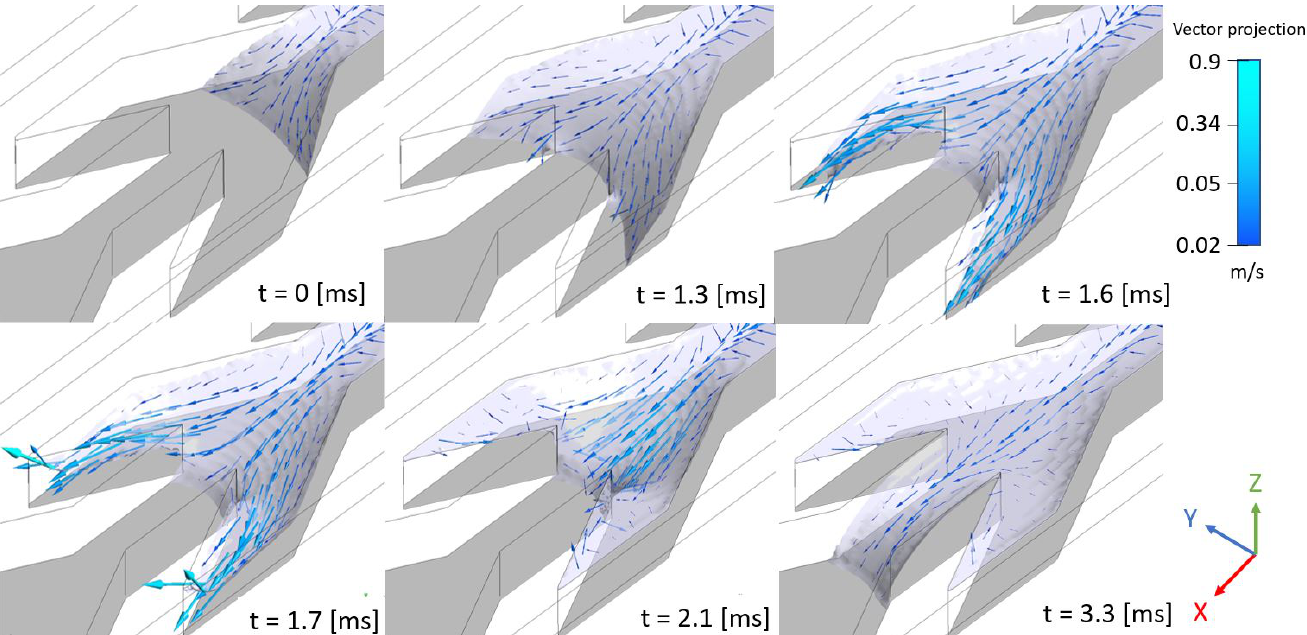
Figure 13. VOF simulation detailing fin filling in the x direction. The continuous color represents the liquid free surface. Arrows display the velocity on the liquid free surface with a color code for the amplitude. However, instead of being started from an initial condition as for Figures 11 and 12, the simulation is issued from the continuous fluid inlet condition described in Section 5.4. The time is set to zero when the liquid enters the V